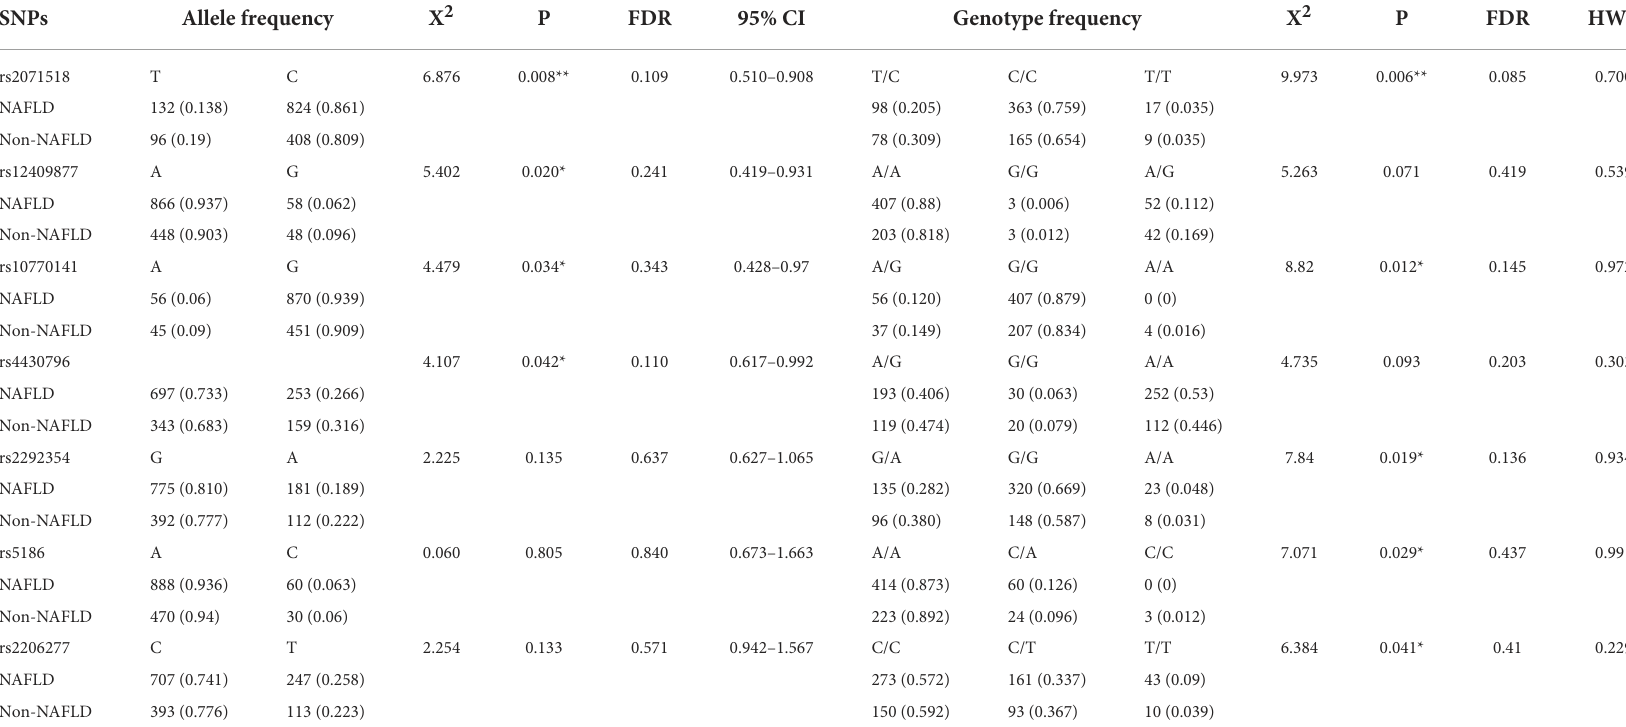
TABLE 3 Allele and genotype distribution in the subjects of the